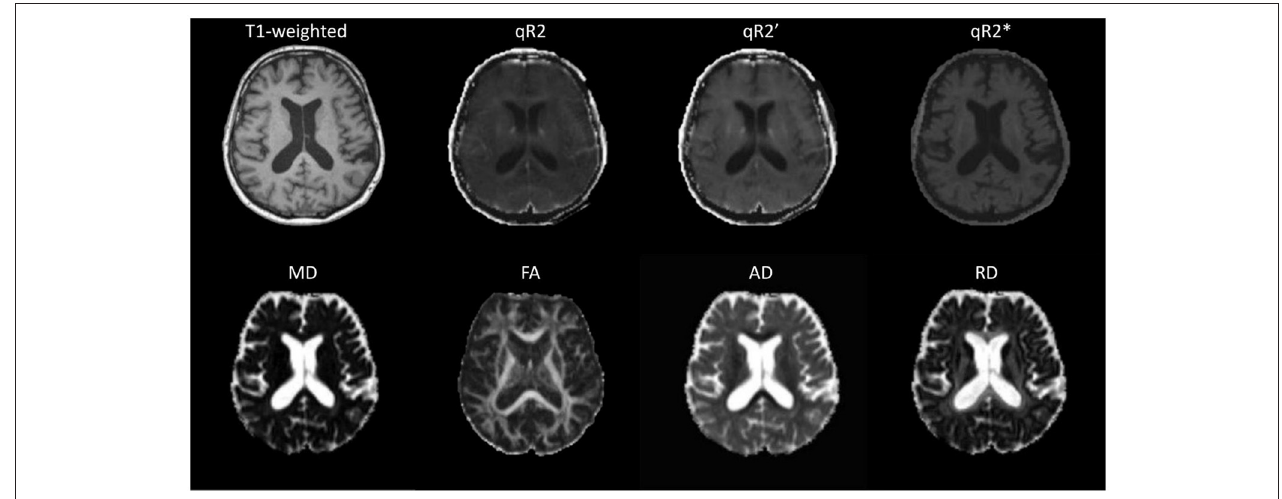
FIGURE 1 | Selected slice from a multi-modal MRI dataset of a patient with Parkinson’s